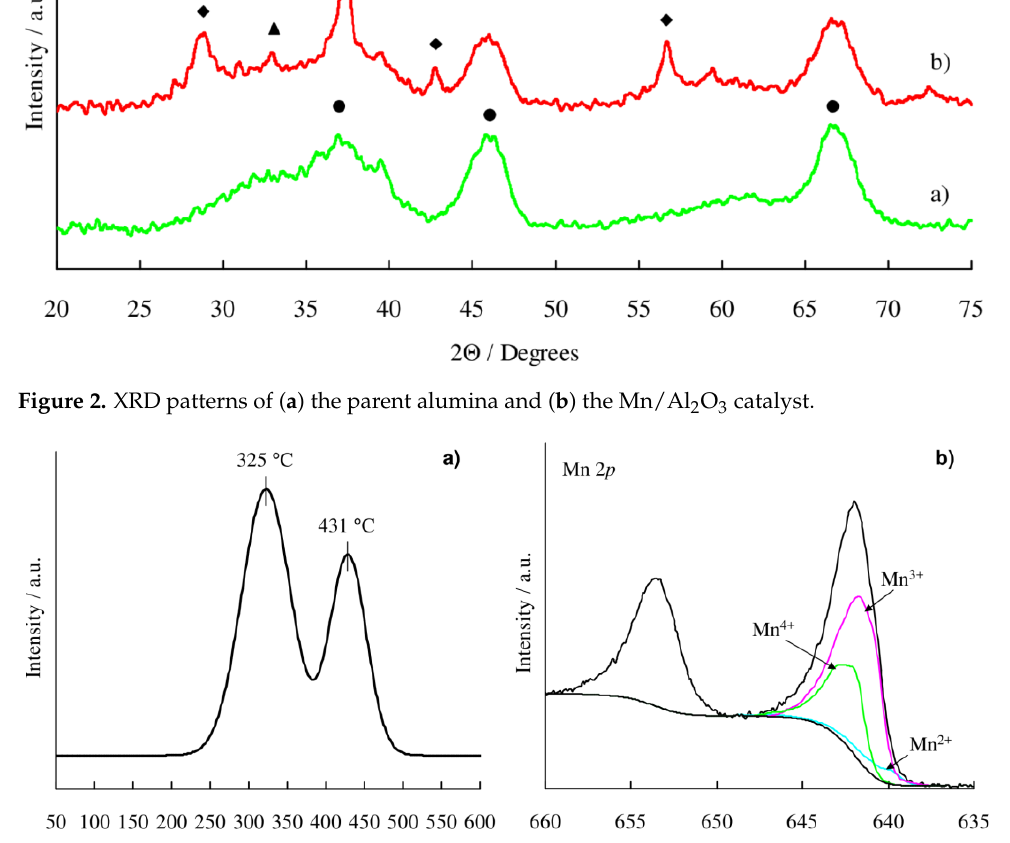
Figure 3. ( a ) H 2 -TPR and ( b ) Mn 2p XPS spectra of the Mn/Al 2 O 3